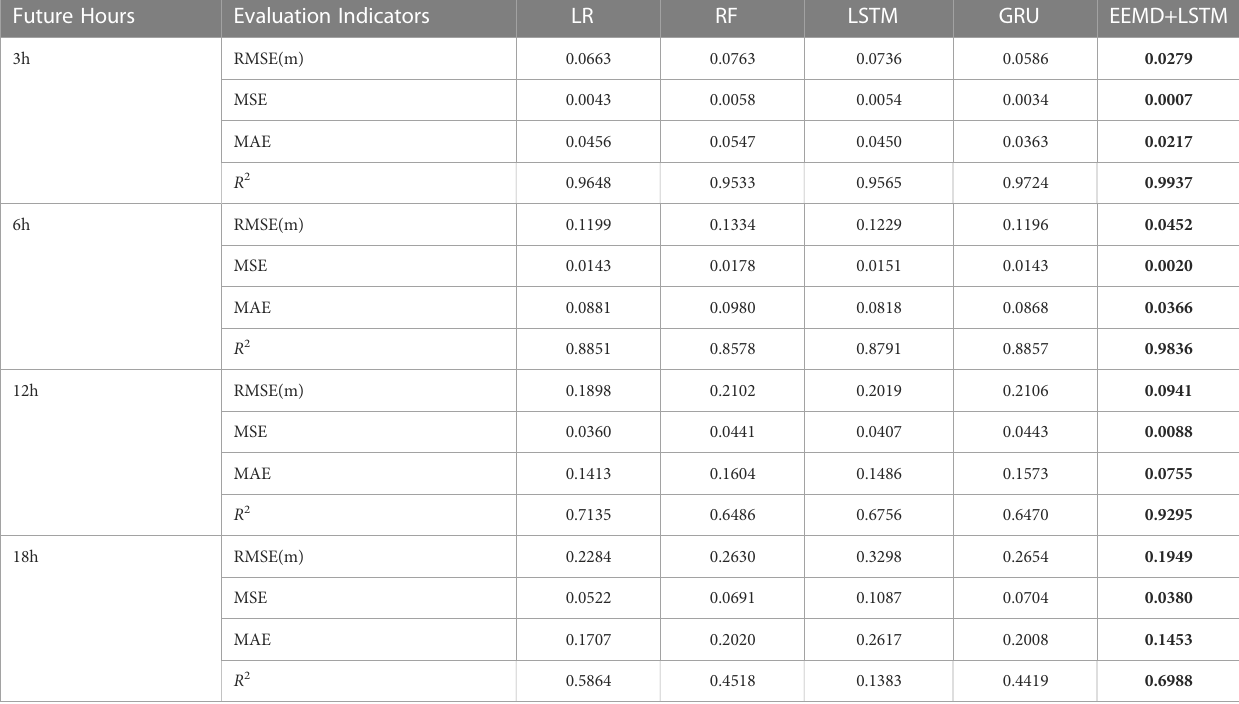
Bold values in the table indicate optimal results scatter points of the EEMD-LSTM model are uniformly distributed on both sides of the line for the predicted SWH in the future 1h, 3h and